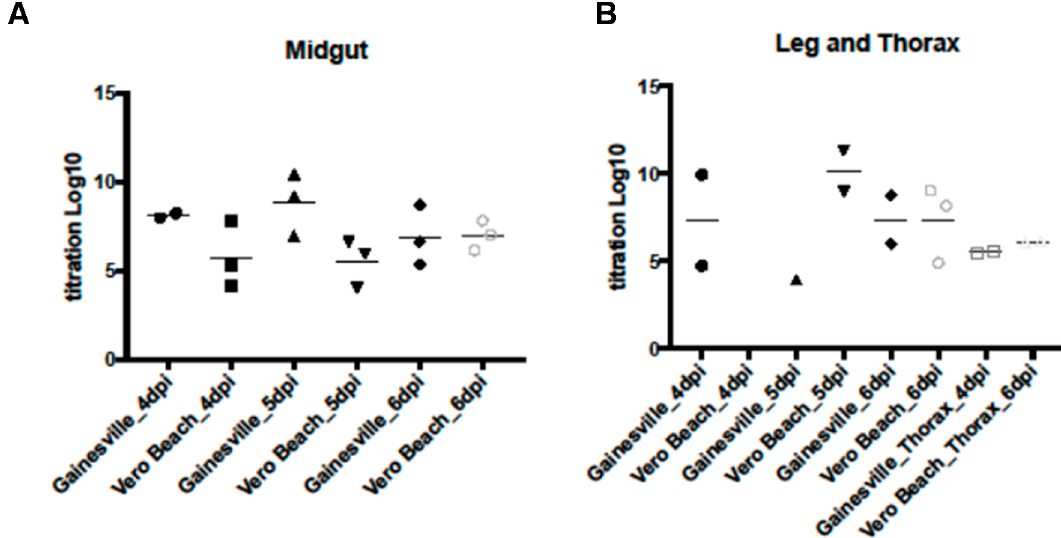
Figure 2. Titration of WNV in tissues dissected from two populations of Cx. quinquefasciatus (CPQG and CPQV) at different incubation periods after infection. ( A ) Titration of WNV from midgut tissues; ( B ) Titration of WNV from leg and thorax tissues. Gainesville = CPQG; Vero Beach = CPQV; dpi = days post infection.